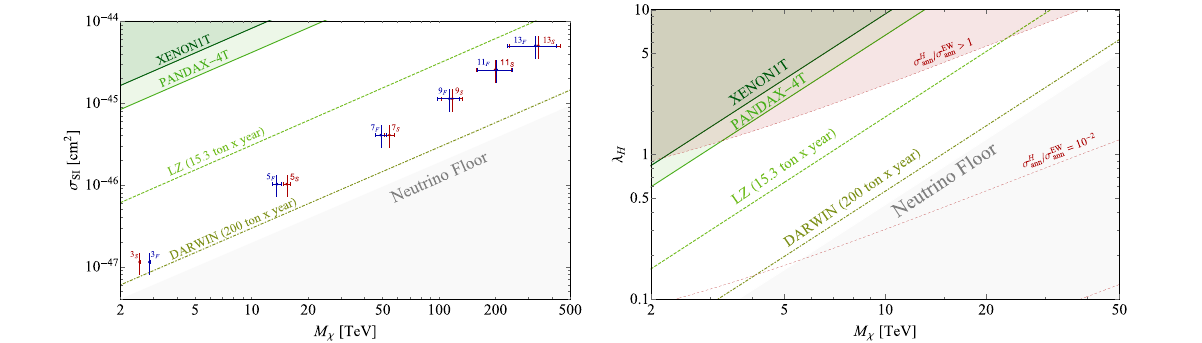
Fig. 8 In dark green we show the present constraints from XENON- 1T [83] and PandaX-4T [84], the green dashed line shows the reach of LZ [85] and the brown green dot-dashed line the ultimate reach of DARWIN [19]. The light gray region show the neutrino floor for 200 ton/year exposure derived in Ref. [86]. Left: expected spin independent (SI) direct detection cross-section for Majorana n -plets (red) and for real scalar n -plets (blue) (assuming the Higgs portal coupling λ H = 0).